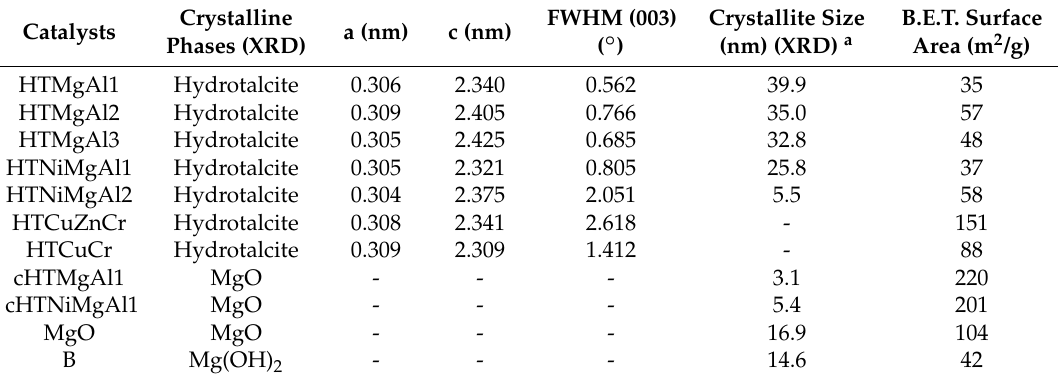
Table 1. Characterization of the catalysts by XRD and N 2 physisorption.